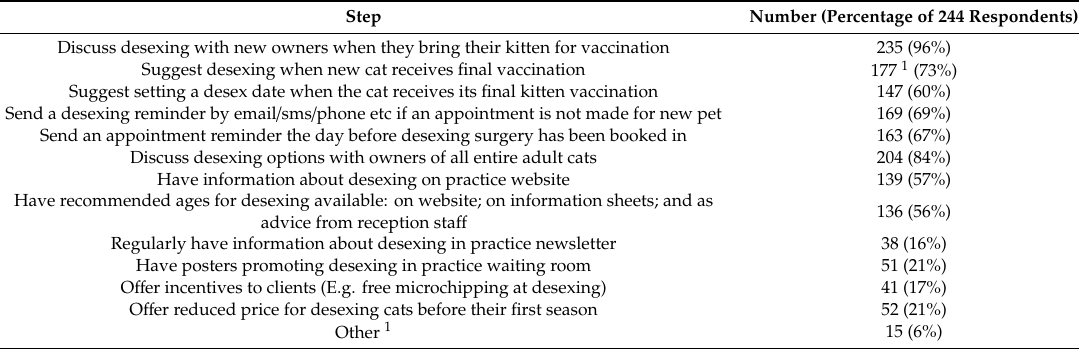
Table 2. Ways in which Queensland veterinary practices promote desexing of